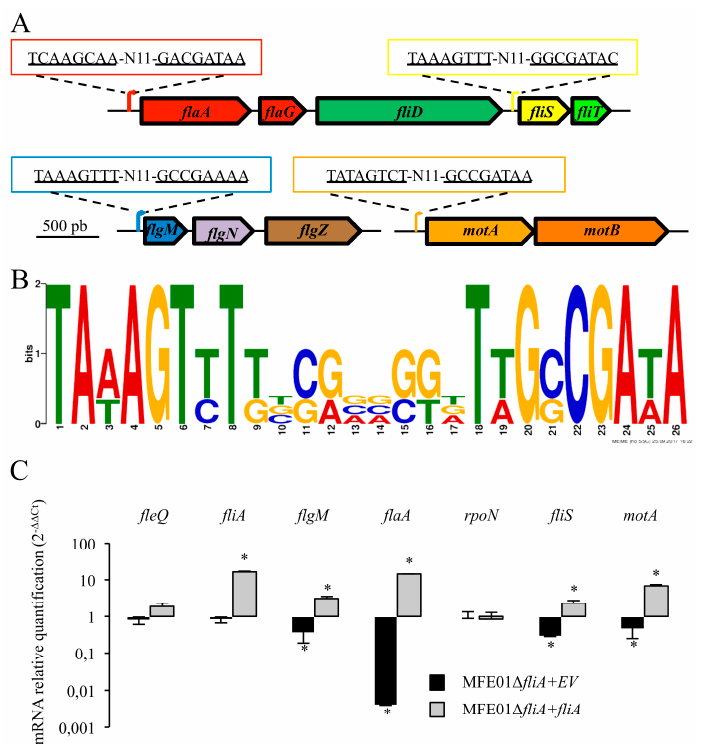
Figure 4. Transcription of flagellar genes in MFE01 and derivatives. ( A ) Putative promoters upstream of flagellar genes. A consensus motif (TAAAGTTT-N11-GCCGATAA), corresponding to promoters recognised by FliA in Pseudomonas aruginosa [40], was used to search for putative FliA-dependent promoters upstream of flagellar genes in MFE01. Sequences corresponding to putative promoters are indicated. ( B ) MEME sequence logo of the four putative promoter motifs. The sequence logo, generated by Multiple Em for Motif Elicitation (MEME), corresponding to the putative FliA-dependent promoters, is shown. ( C ) Flagellar gene expression in MFE01 ∆ fliA + EV and MFE01 ∆ fliA + fliA . The reported mRNA levels are relative to those obtained in MFE01 carrying the empty pPSV35 vector. Relative levels